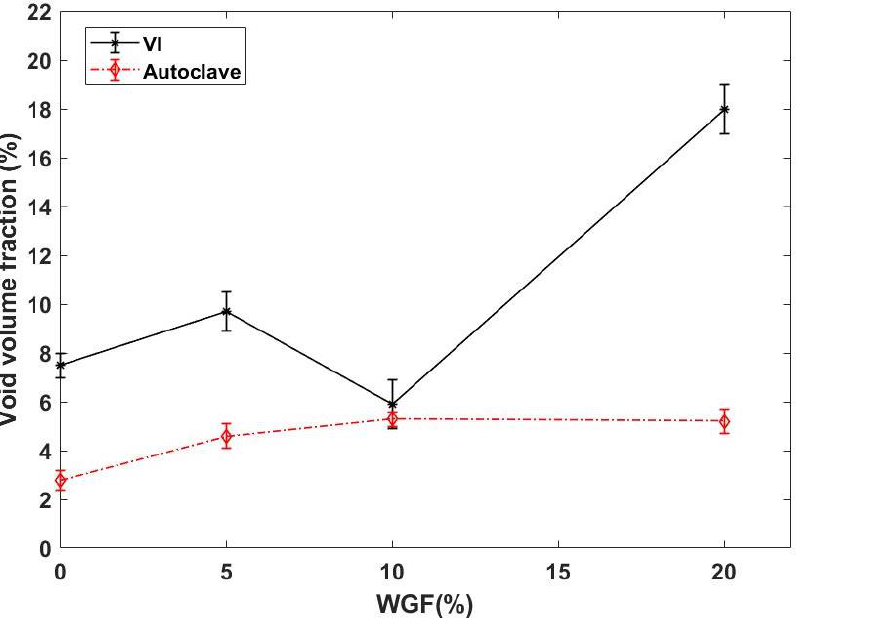
Figure 7. Residual void volume fraction of WGF composites manufactured using two different